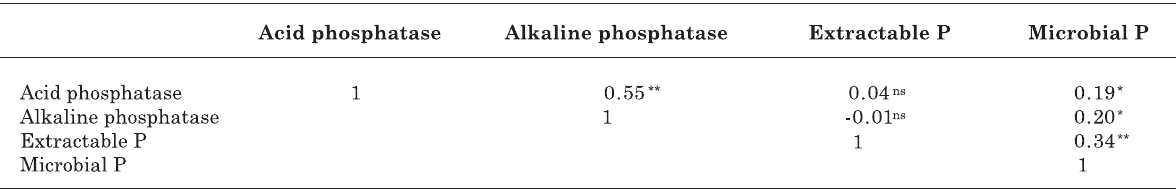
Table 3. Pearson correlation coefficients between acid and alkaline phosphatase activity levels, extractable P, microbial P in sandy soil sampled during the first winter growing season